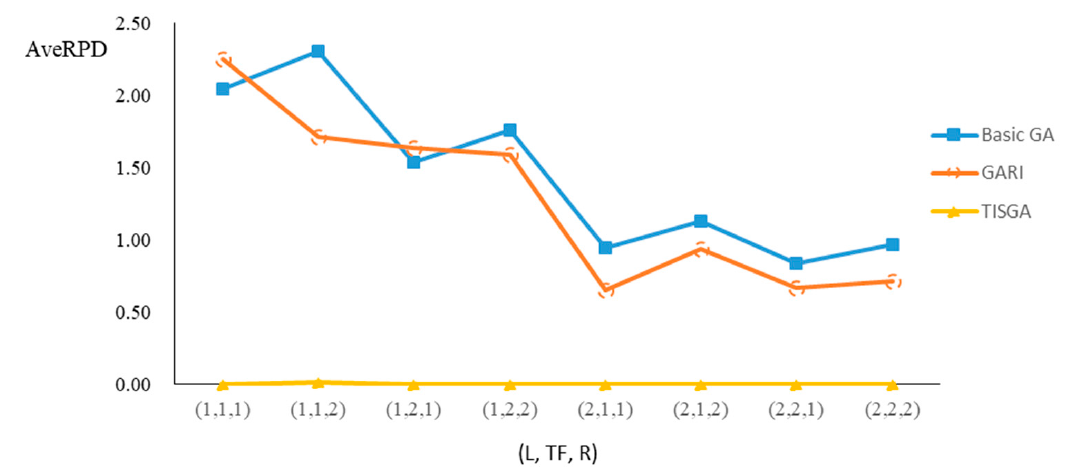
Figure 15. Comparison results for n = 60 with eight combinations of (L, TF, R).